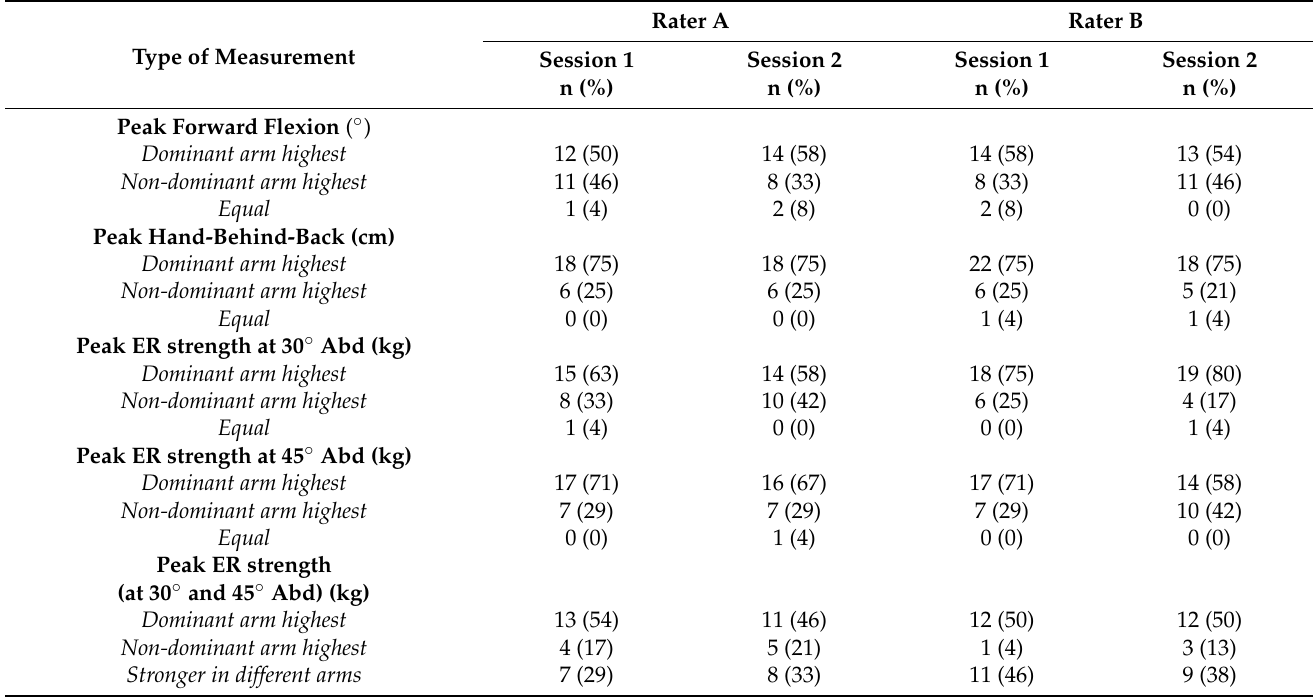
Table 6. Peak measurement comparisons between dominant and non-dominant arm (n =